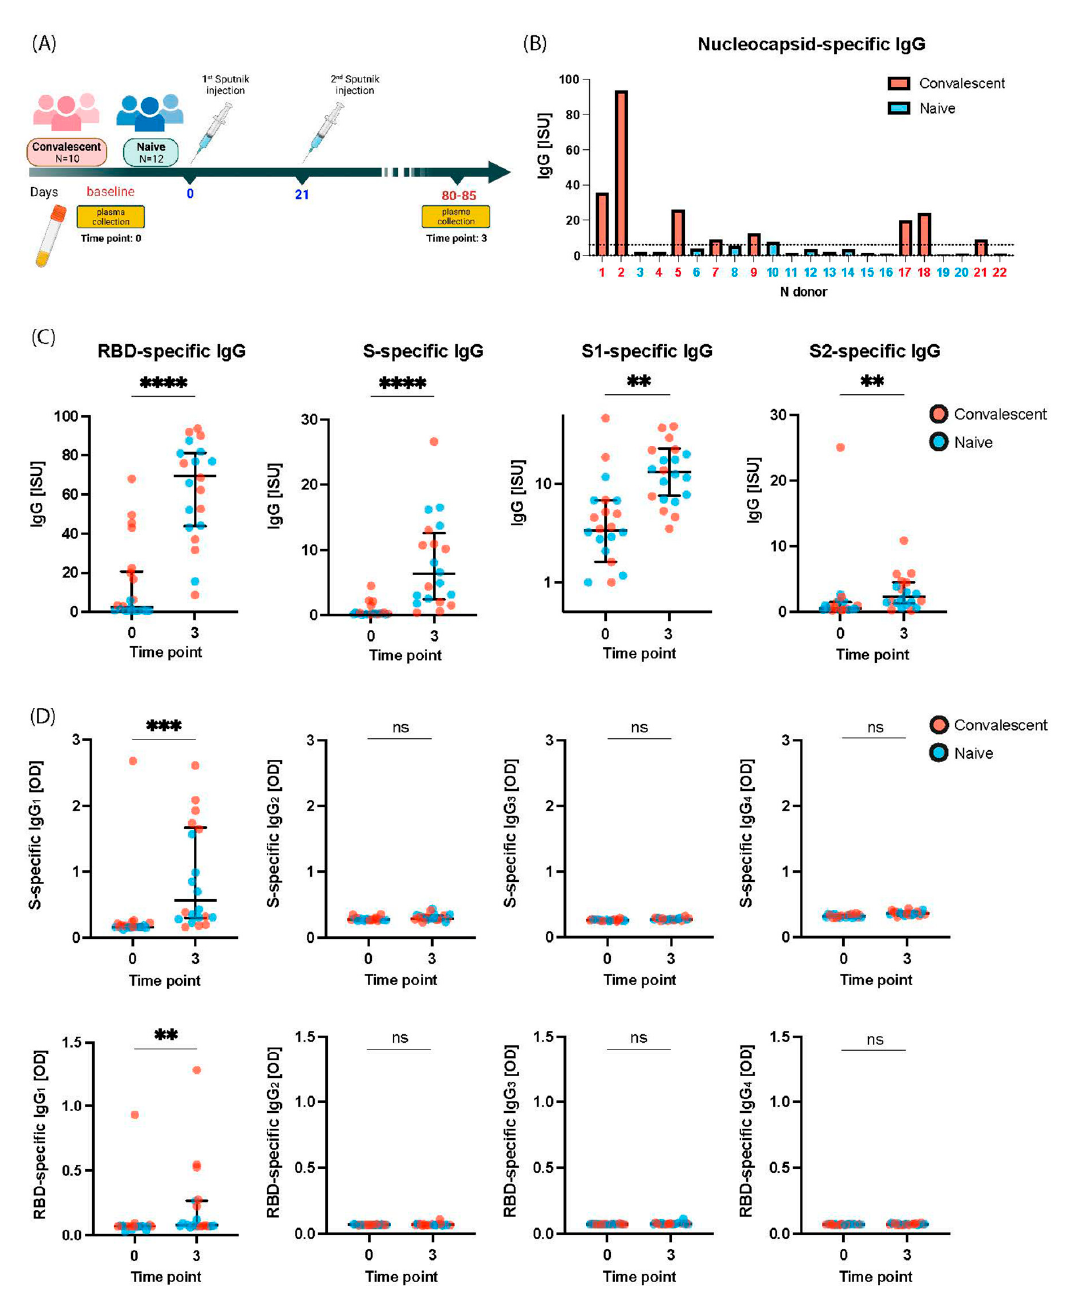
final vaccination one subject (i.e., subject 22) had COVID-19 whereas the others had not developed any symptoms of COVID-19 (Table 1).